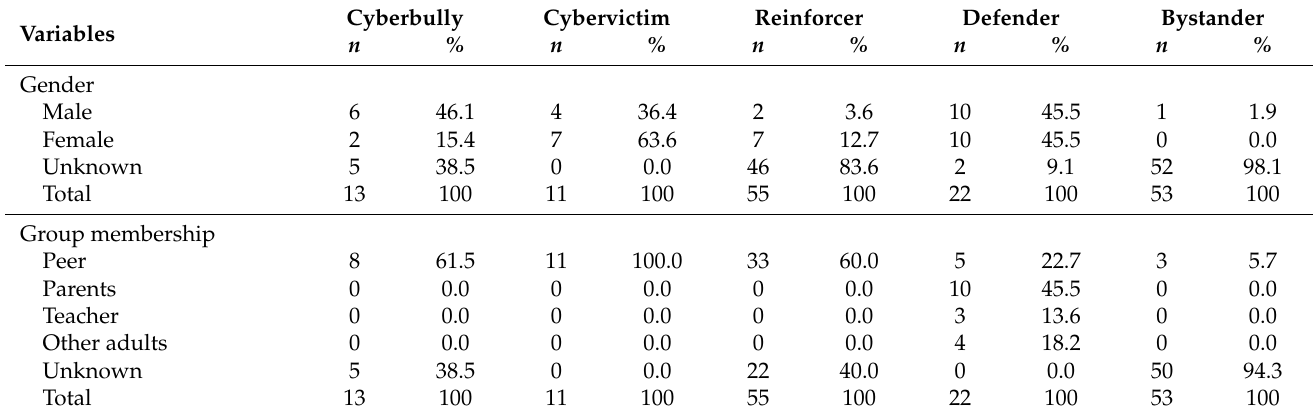
Table 4. Characters in terms of role, gender, and peer or adult group